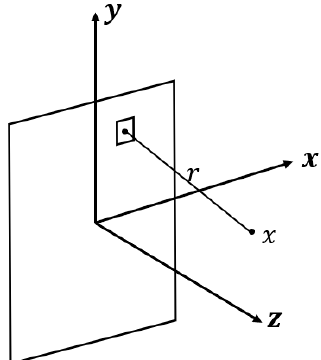
Figure 1. Fast algorithm coordinate system.